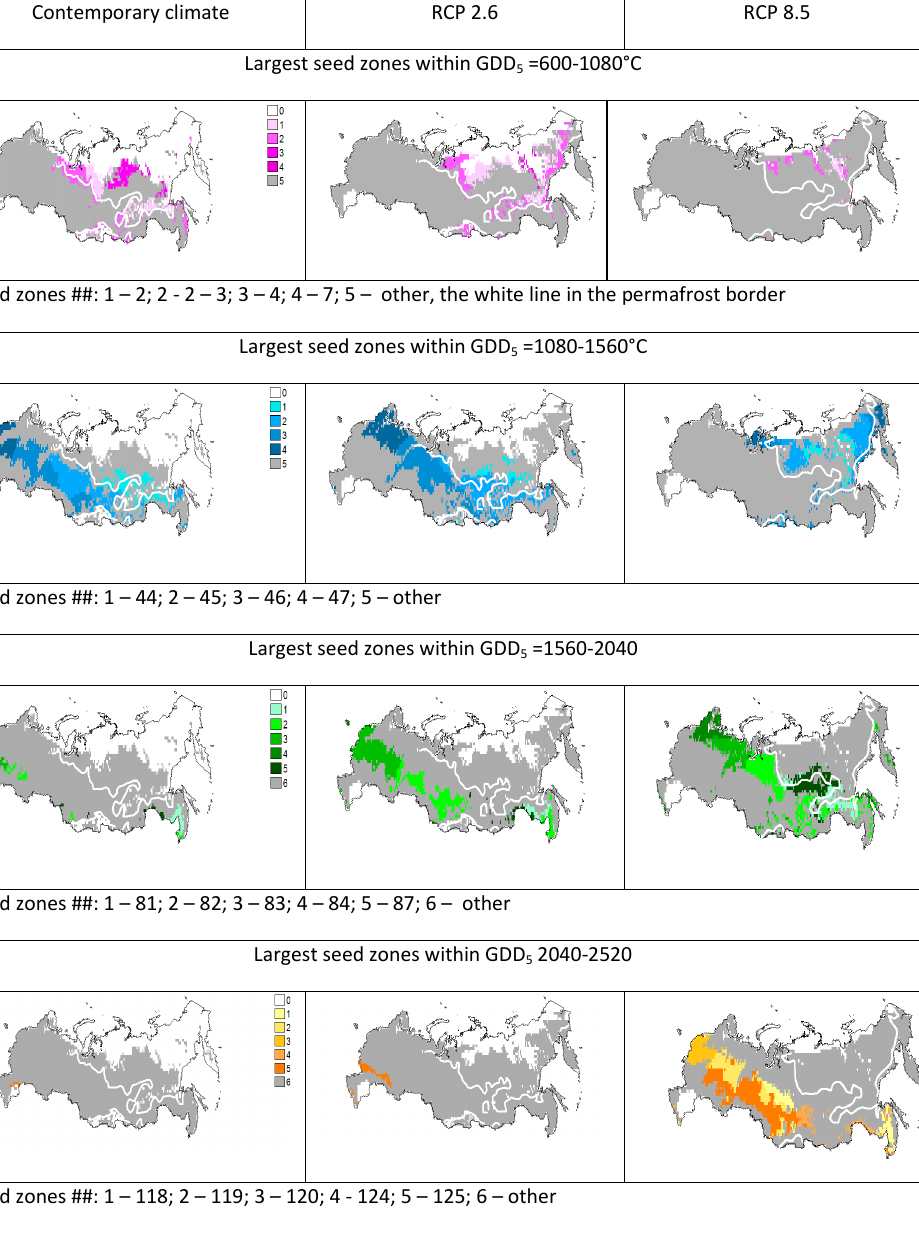
Figure 4. Distributions of large seed zones (>5% of the total seed zone area) across Russia in contemporary climate ( Left ) and future RCP 2.6 ( Central ) and RCP 8.5 ( Right ) climates in 2080. The white line is the permafrost border that divides the realized (below the border) and non-realized (above the border) seed zones.